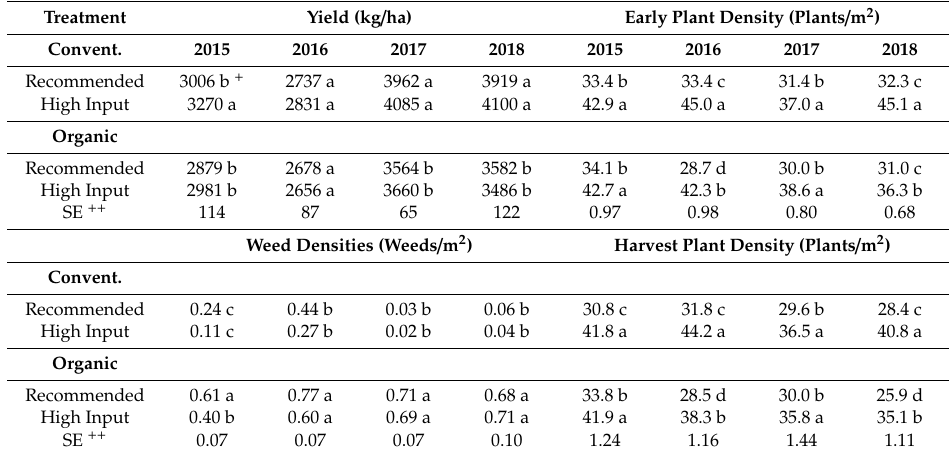
Table 6. Seed yield, early soybean plant density (2 weeks after planting), weed density (at the full pod stage) and harvest soybean plant density in 2015, 2016, 2017 and 2018 under conventional (Convent.) and organic farming systems with recommended and high input management at a University Research Farm in central New York, USA. Treatment Yield (kg /